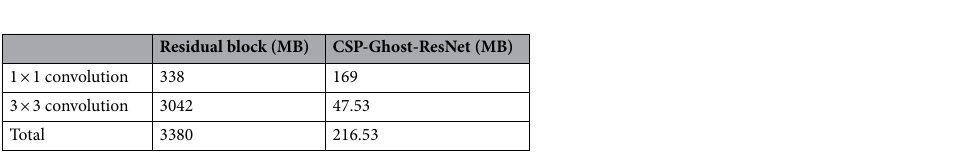
Table 1. FLOPs of the first stacking module of the Residual block and CSP-Ghost-ResNet.